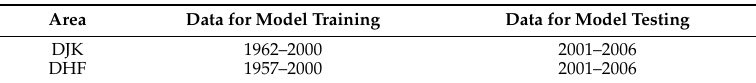
Table 4. Data used for training and testing the relevance vector machine (RVM) model and